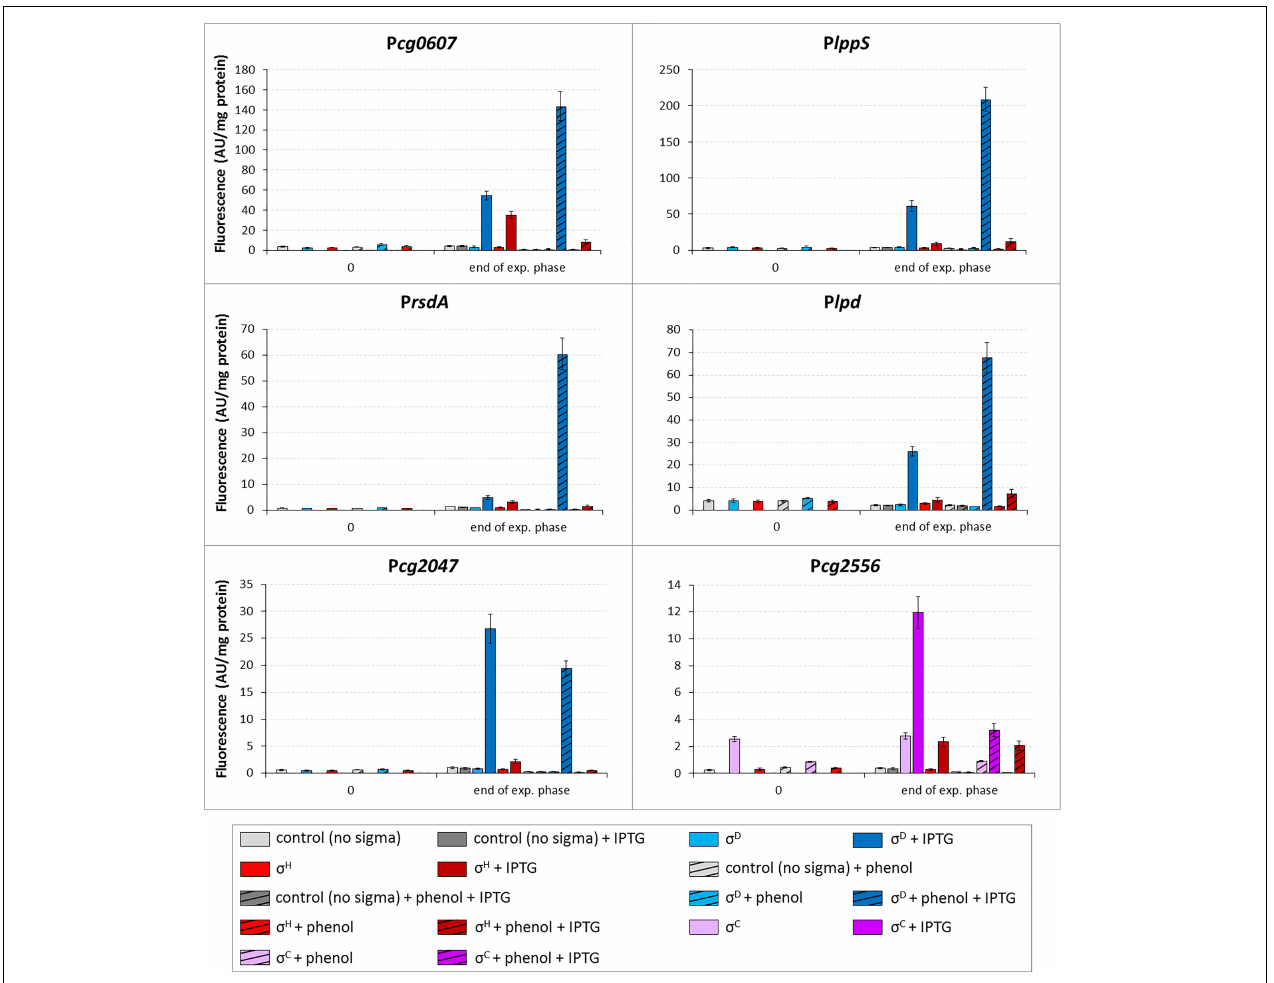
FIGURE 9 | Effect of phenol on activity of σ D -dependent promoters. The C. glutamicum strains carried the vector pEC-XT99A overexpressing sigH (red bars), sigD (blue bars) or sigC (purple bars) after the addition of IPTG (added at OD 600 = 1; dark bars) and the promoter-test vector pEPR1 constructs carrying the tested promoters (above the graphs). The strain overexpressing sigC and harboring pEPR1 with the σ C -dependent promoter P cg2556 (Dostálová et al., 2017), which is not activated by phenol, was used as a control (purple bars). Phenol (3.4 mM) was present in media from the beginning of cultivation (hatched bars). Plasmids carrying the pEPR1 construct and empty pEC-XT99A were used as controls (gray bars). The samples were taken at OD 600 = 1 (0) and at the end of exponential growth phase. AU, arbitrary units. The standard deviations of three biological replicates are depicted by error